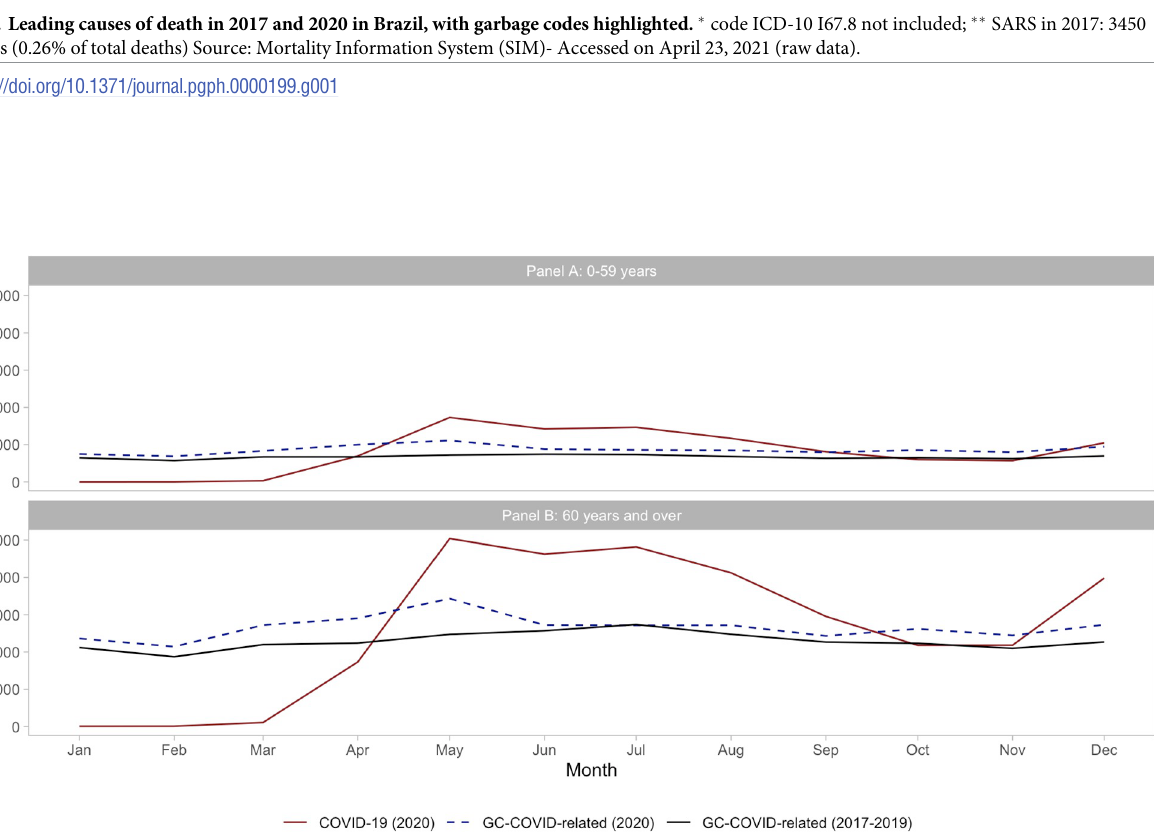
PLOS Global PublicHealth | https://doi.org/10.1371/journal.pgph.0000199 May 5,